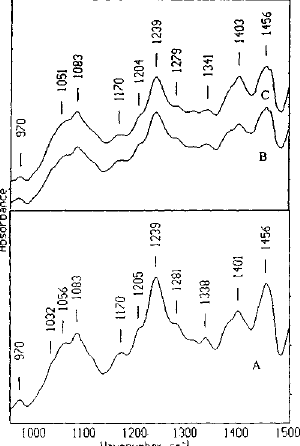
Fig. 4. This figure shows the differences among the representative FTIR spectra in the frequency region 950 to 1500 cm (cid:0) 1 of human breast (A) invasive infiltrating ductal carcinoma (IIDC), (B) simplex, (C) medullary carcinomas: this band near 1170 cm (cid:0) 1 in IIDC sam- ple is sharper and stronger than that in simplex and medullary carci- nomas; the ratio of A 1238 = A 1403 in the spectrum of simplex carcino- mal tissue is lower than that of medullary